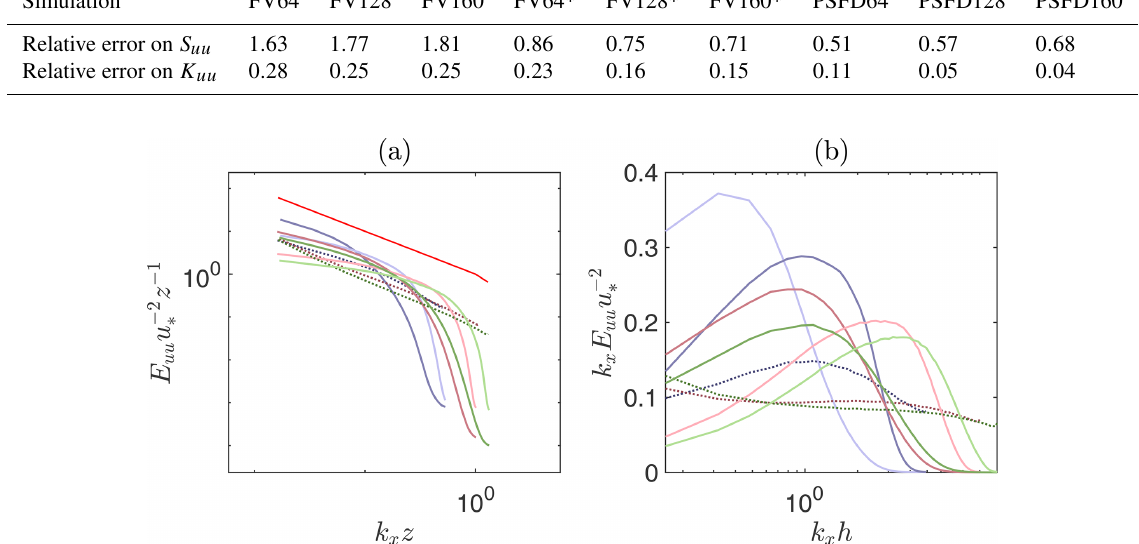
Figure 3. (a) Normalized one-dimensional spectra of streamwise velocity at z/h ≈ 0 . 1. The solid red line depicts the (k x z) − 1 production range and (k x z) − 5 / 3 inertial subrange scaling. All other lines as in Fig. 1. (b) Premultiplied one-dimensional spectra of streamwise velocity at z/h ≈ 0 .